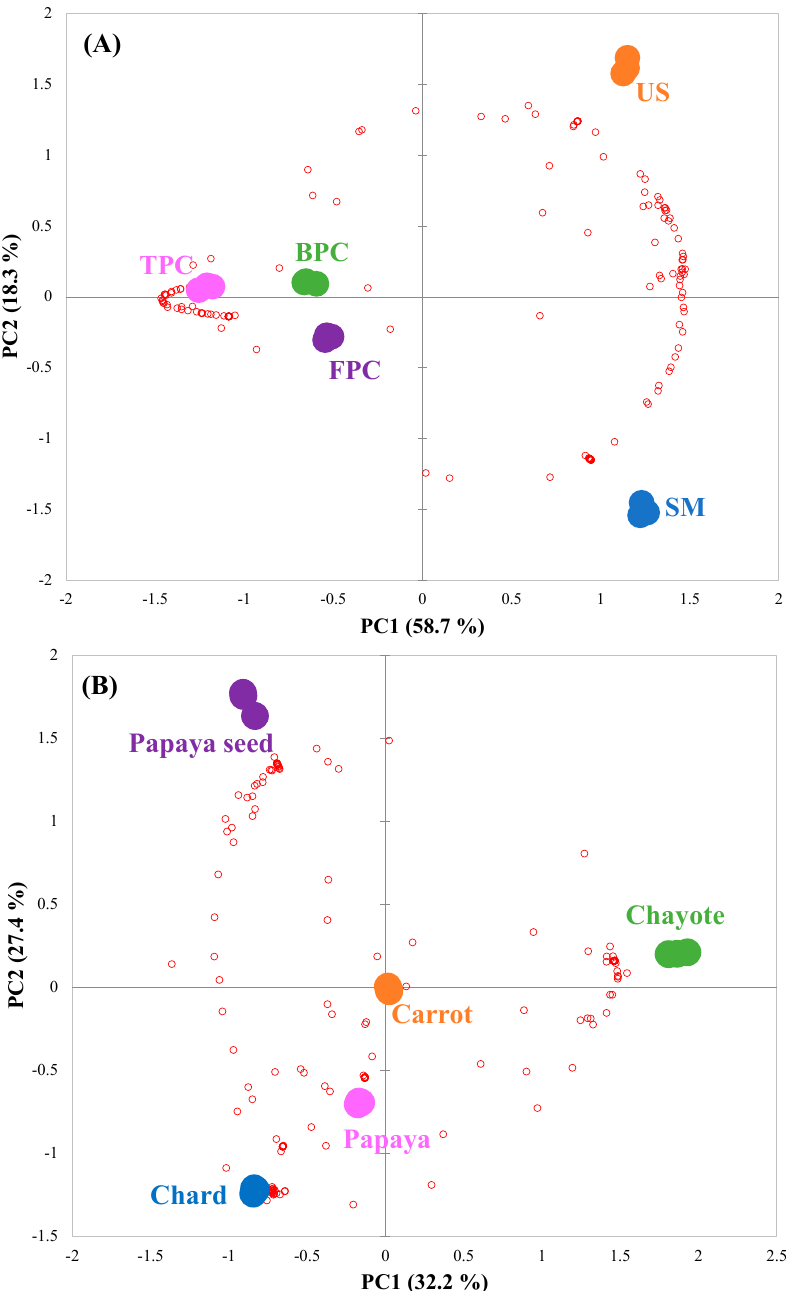
Figure 4. Principal component analysis (PCA) biplot to observe the similarity/dissimilarity between ( A ) the extract used, independent of the fruit and vegetable by-products (FVB), and ( B ) the fruit and vegetable by-products (FVB), regardless of the extract. The samples (symbols) are distributed according to relative intensity of identified phenolic compounds (red circles).